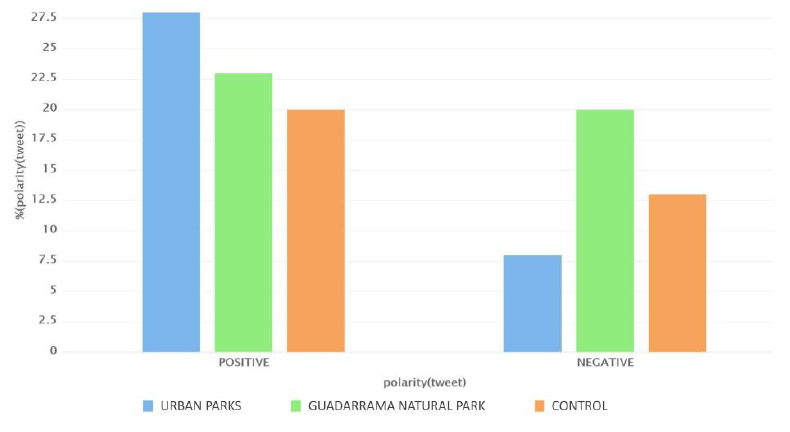
Figure 4. Comparison of feelings among the three main